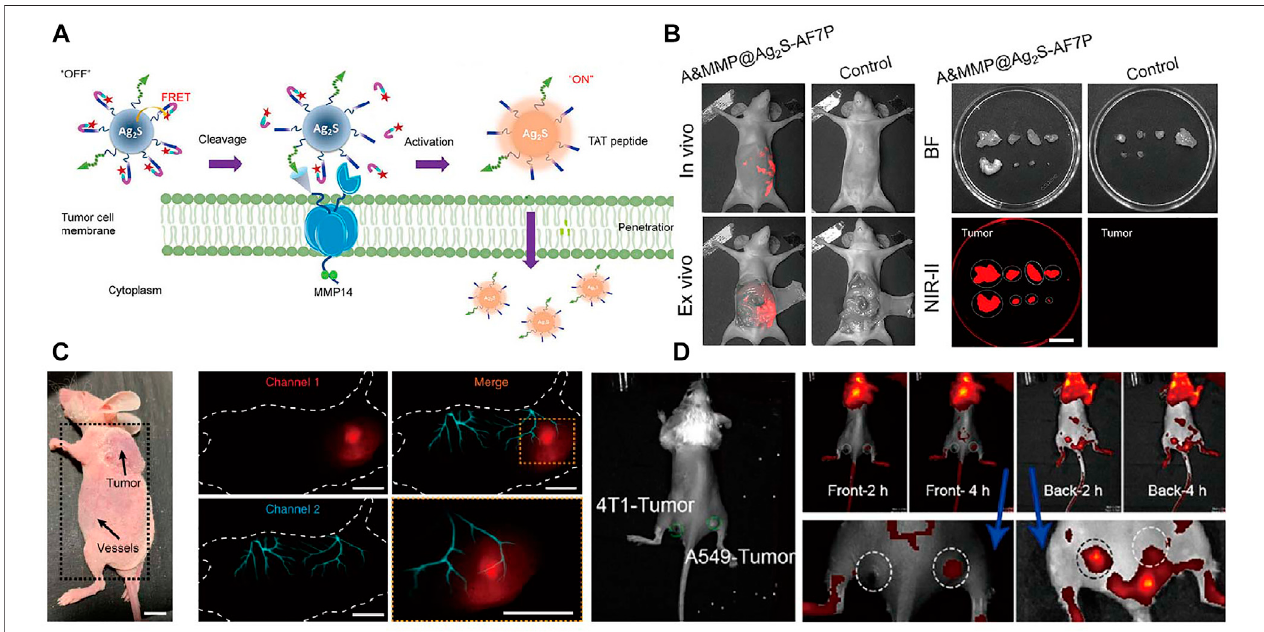
FIGURE 5 | Representative reporters of tumor diagnosis using NIR fl uorescence. (A) Schematic illustration of A&MMP@Ag 2 S-AF7P for NB detection. (B) A&MMP@Ag 2 S-AF7PNIR-II fl uorescentandbright fi eldimageofexcisedtumornodulesforpre-operativeandpostoperativestageofperitonealtumor(Zhanetal.,2021). ReproducedwithpermissionfromWangetal.(2021). (C) Dual-channelNIRbioluminescenceimagingofCT-26tumortissue(upper)andvessels(lower).(Luetal.,2020). ReproducedwithpermissionfromZhangetal.(2020). (D) Invivo NIRimagingofthemouseinoculatedwith4T1andA549tumorcells(Lvetal.,2021).Reproduced with permission from Tian et al. (2021).